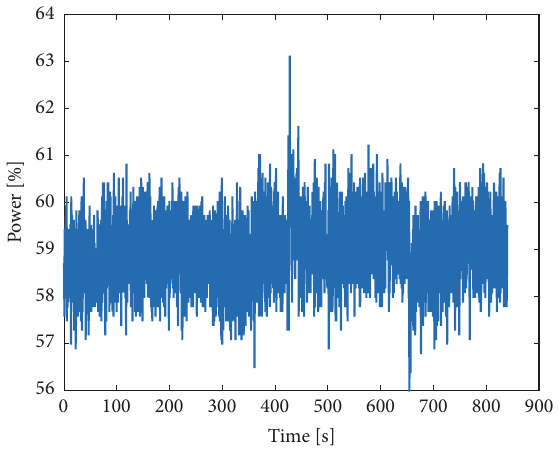
Figure 2: Stable signal from a typical BWR.